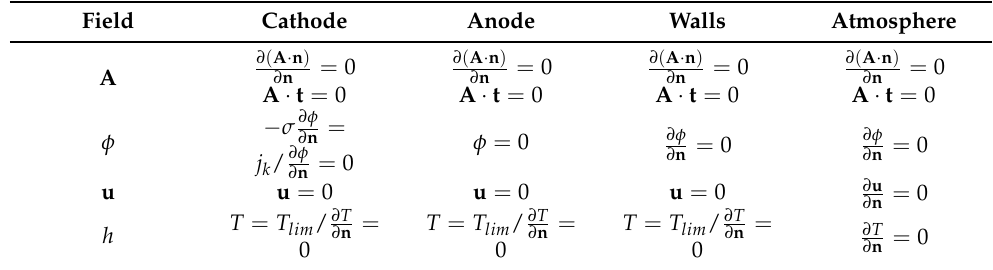
Table 2. Boundary conditions for MHD-CFD model (see Figure